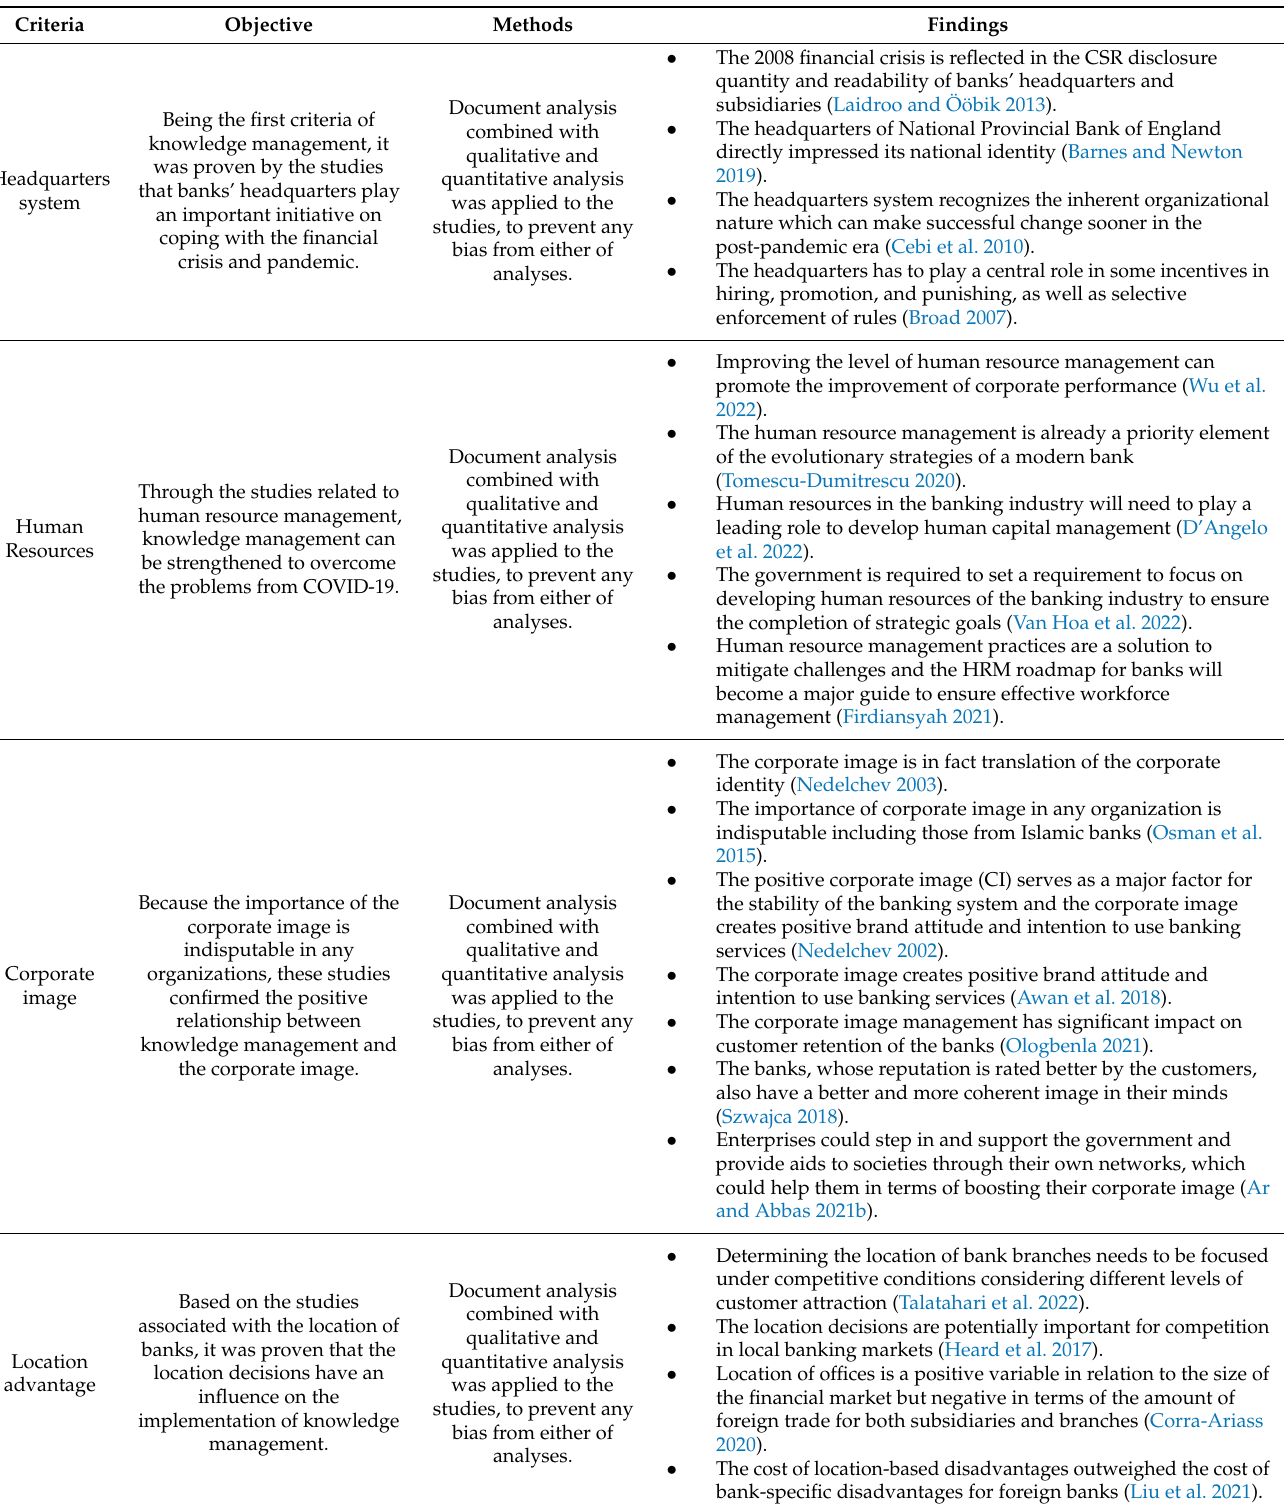
Table 1. Summary of the seven